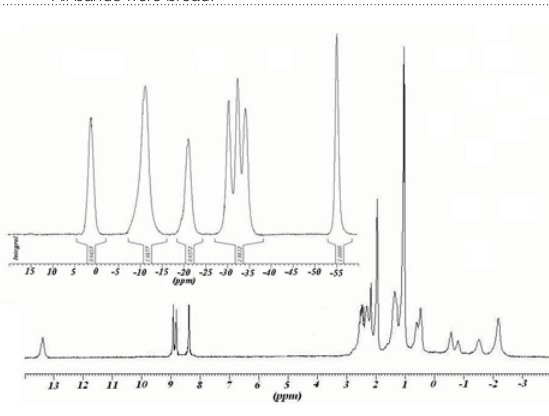
Figure 2. 11 B (insert) and 1 H NMR spectra of compound 3 .